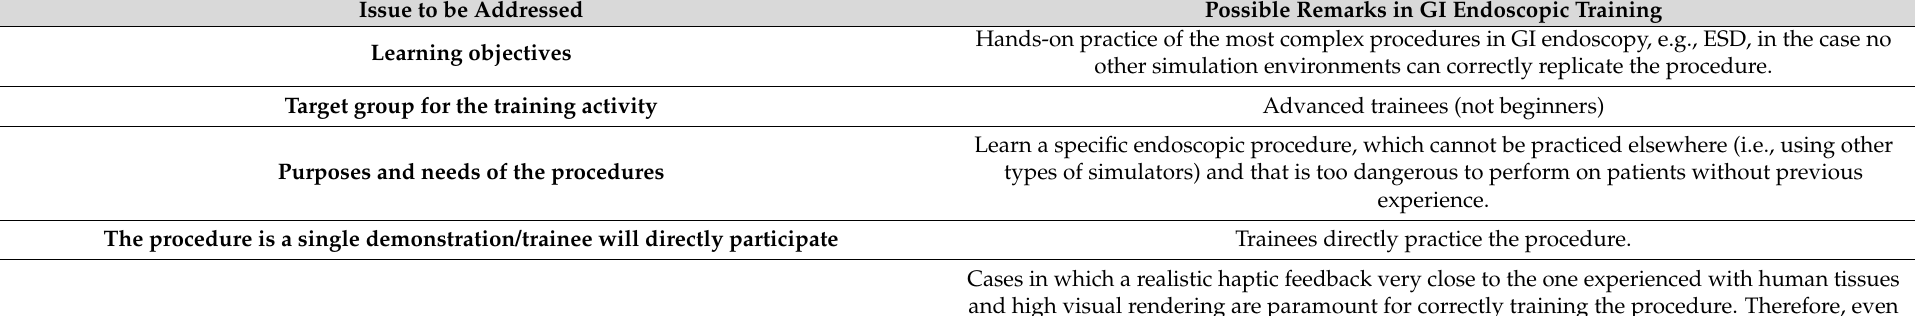
Table 3. This table illustrates how to justify the GI endoscopic training scenario under the requirements for caring for animals aiming for better science